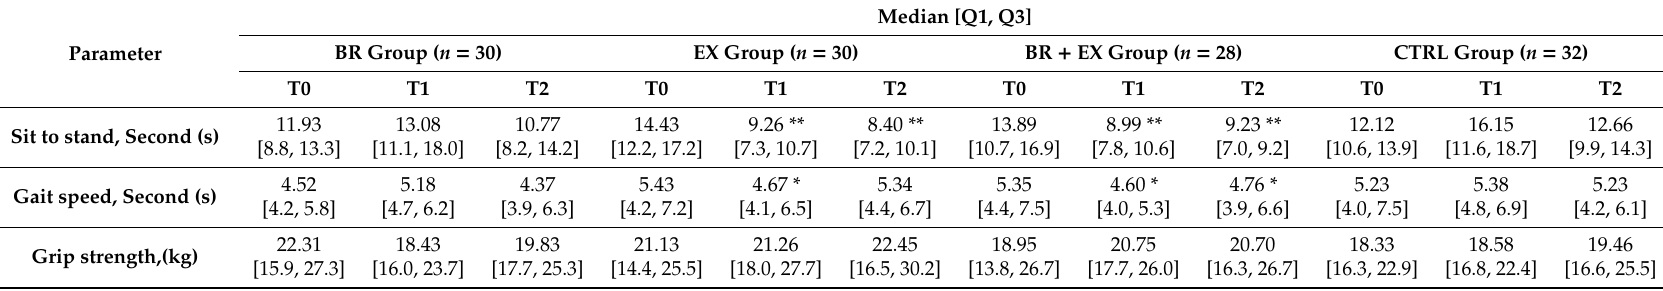
Table 6. Changes in physical performances and muscle strength parameters in all 4 di ff erent intervention groups during the 24-week intervention period (T0 = baseline, T1 = 12 weeks, T2 = 24